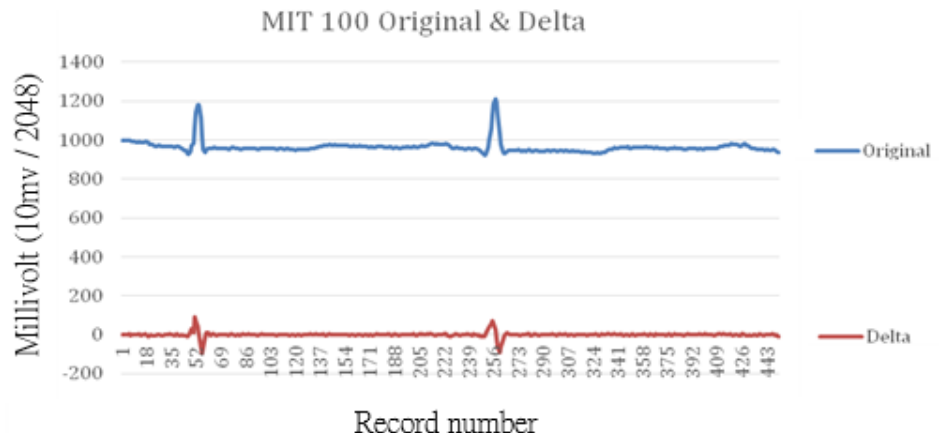
Figure 4. MIT/BIH Arrhythmia Database recording 100 original ECG volumes and delta volumes.